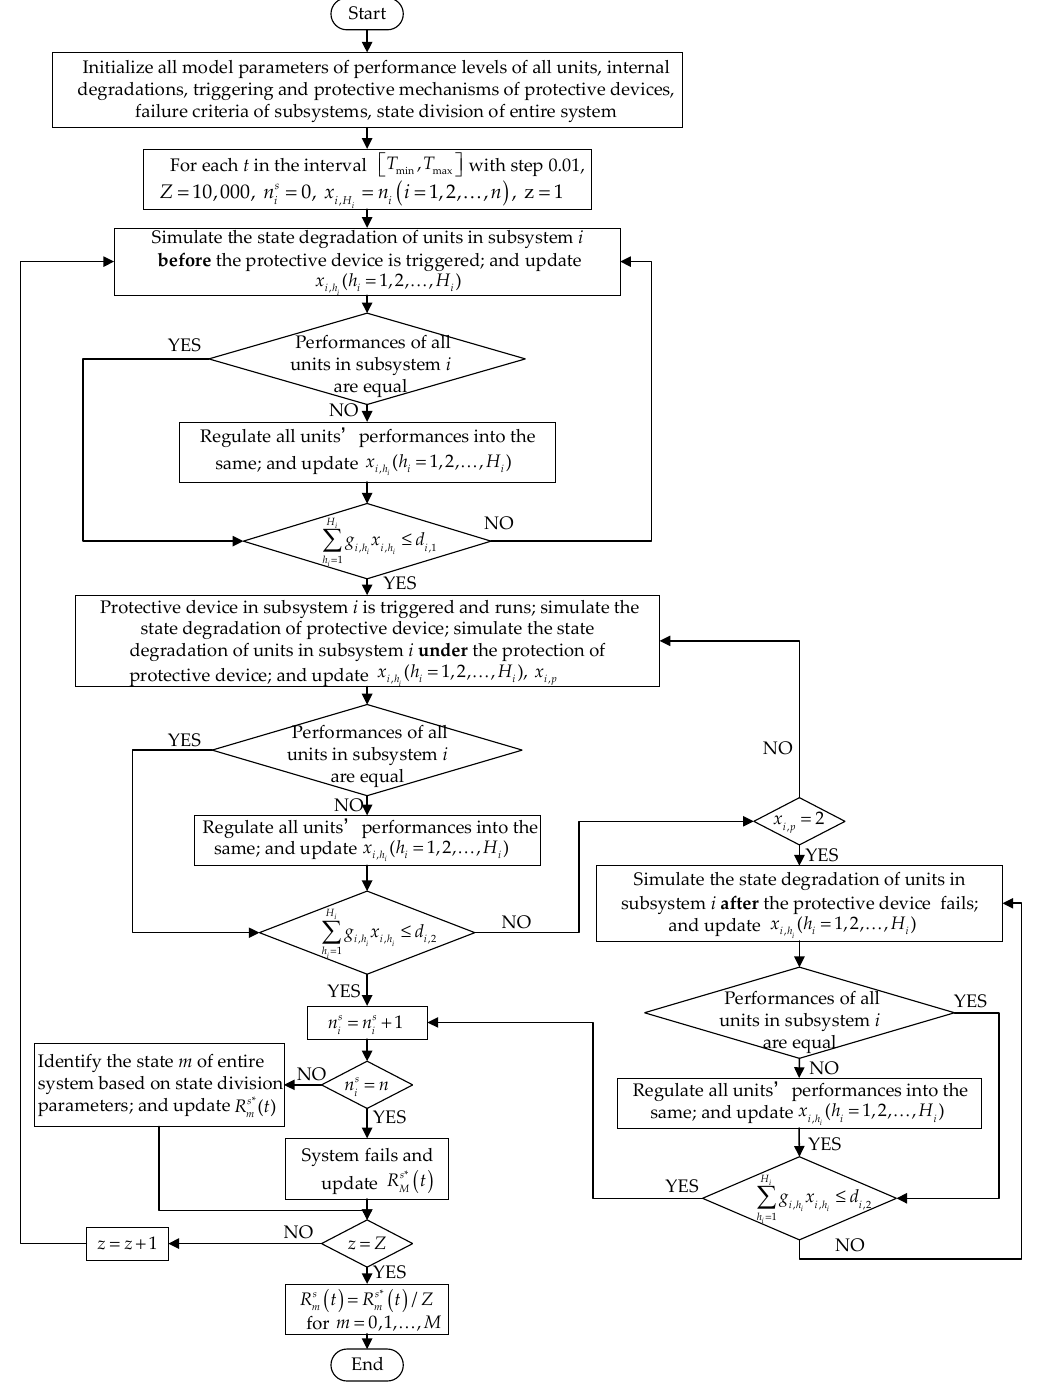
Figure 8. Simulation algorithm for deriving the state probability function of an entire system.